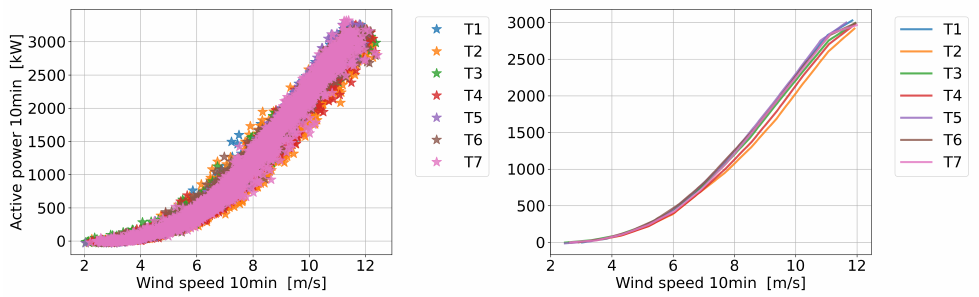
Figure 14. Power curve for the whole wind farm, computed using the binning method: 2022, upon nacelle anemometer replacement at wind turbine